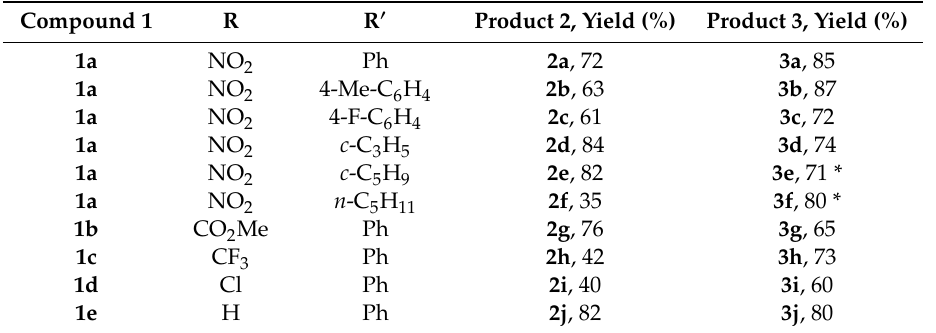
Table 1. Isolated yields of compounds 2a – j and 3 a – j.